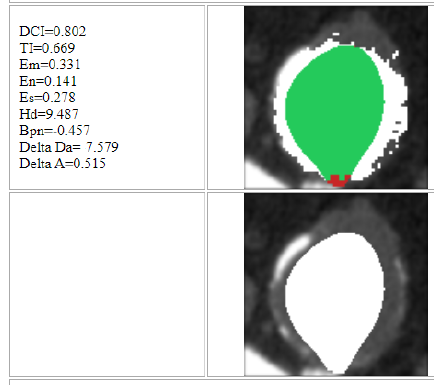
Figure 7. Results of the entire